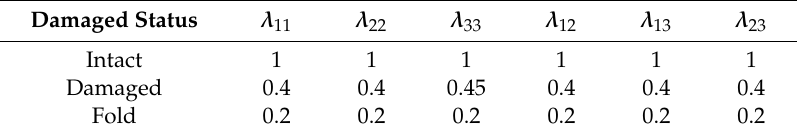
Table 7. Equivalent sti ff ness reduction factor of